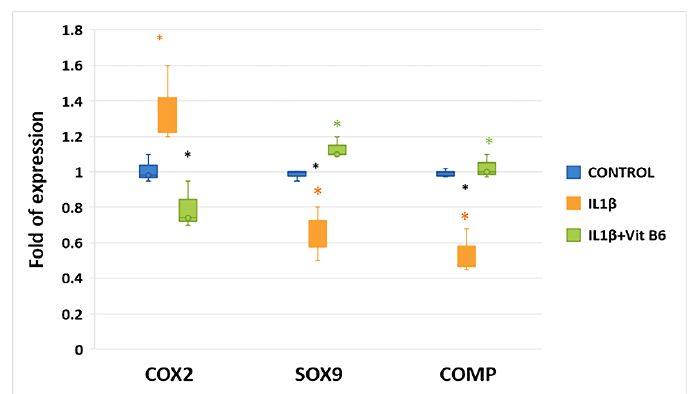
Figure 6. The presence of 1 ng/mL IL1β caused an increase of the inflammatory factor COX2